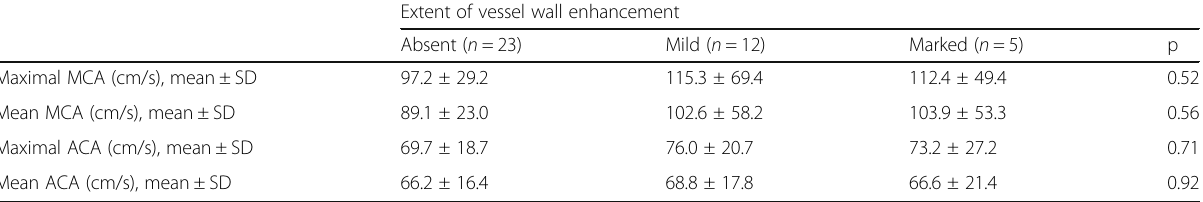
Table 2 Cerebral blood flow velocity in RCVS patients with different degrees of vascular wall enhancement Extent of vessel wall enhancement